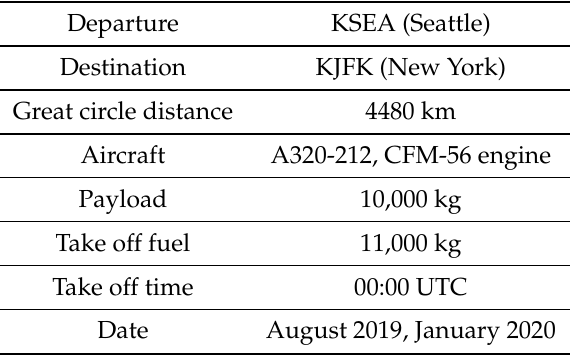
Table 1. Scenario input parameters.